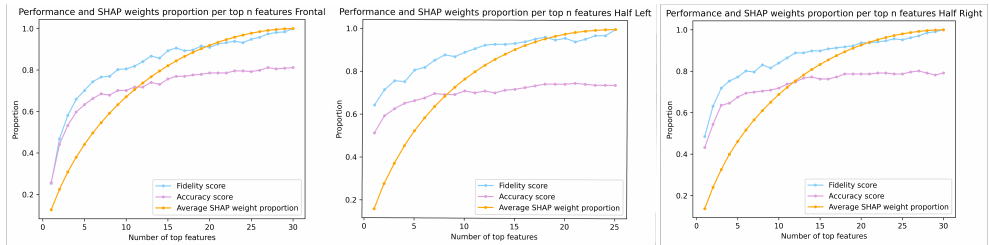
Figure 3. Fidelity and accuracy scores per top n SHAP features for the frontal, half left and half right model. Also given is the proportion of the SHAP weight of the top n features with regard to the total weight of all features. All scores are calculated on the test